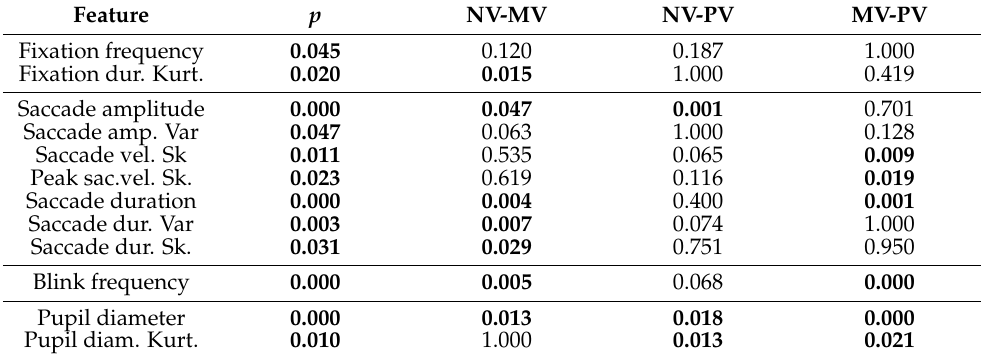
Table 7. Results of Mixed Linear Model (MLM) and post hoc tests for valence